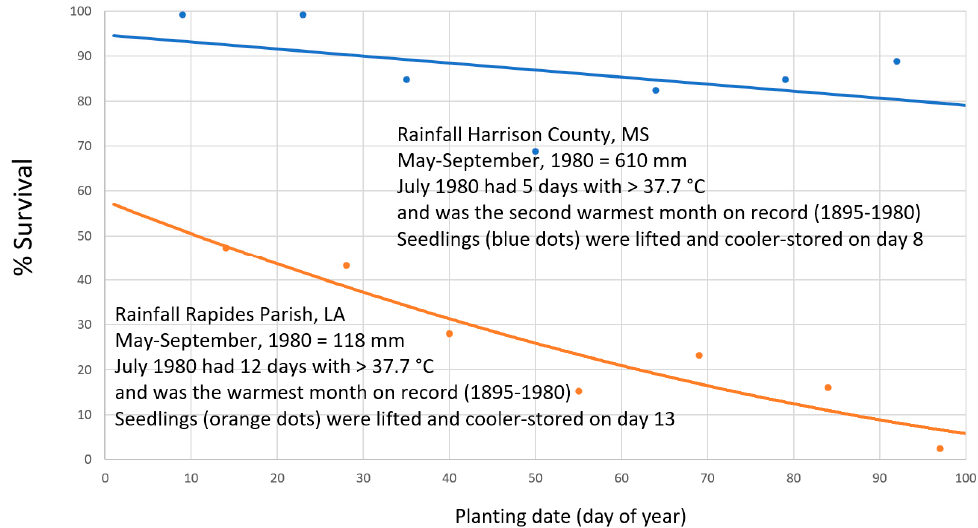
Figure 22. Bareroot longleaf pine seedlings were treated with clay slurry just before hand-planting on sites at the Palustris Experimental Station (Louisiana) and the Harrison Experimental Station (Mississippi). Data from [163] Seedling survival was recorded in October of 1981. For Harrison County, p > |t| = 0.17 for intercept and 0.31 for slope; R 2 = 0.20. For Rapides Parish, p > |t| = 0.0001 for intercept and 0.002 for slope; R 2 = 0.87.